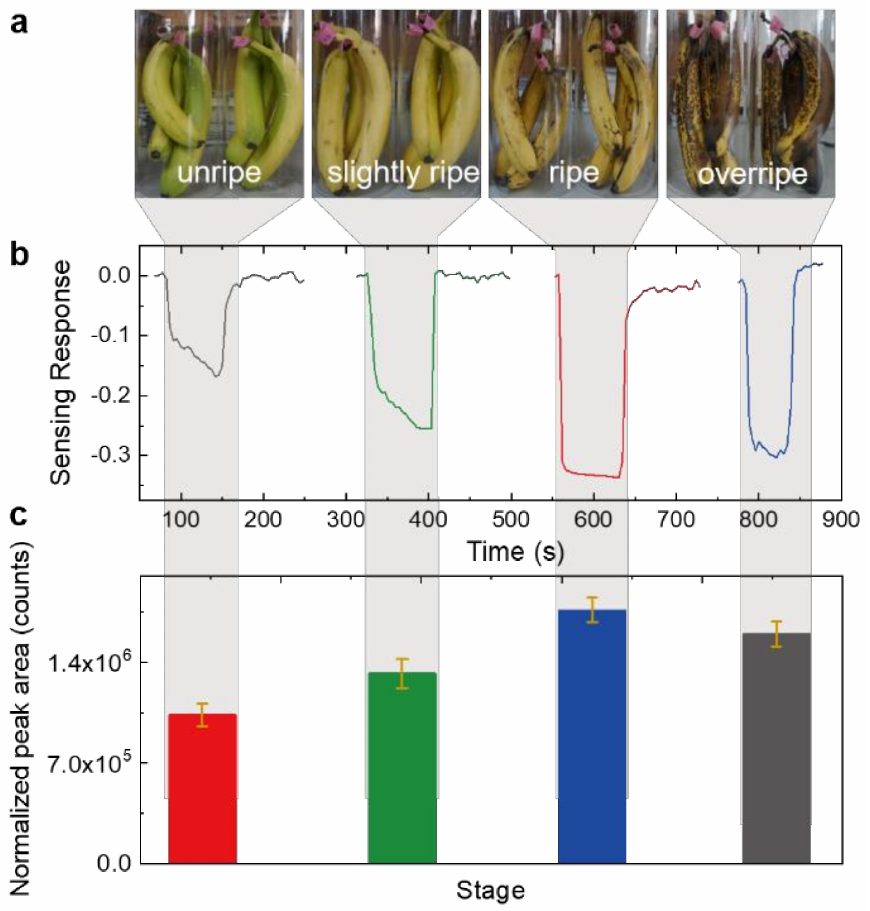
Figure 5. ( a ) Photos of banana samples at different storage stages: yellowish green (1st stage, unripe), all yellow (2nd stage, slightly ripe), all yellow with brown speckles (3rd stage, ripe), and dark brown (4th stage, overripe). ( b ) The real-time resistance versus time curves of the rGO/WSe 2 /Pd heterojunction-based chemiresistive sensor when placed into the sealed container with bananas at different ripeness stages. ( c ) The normalized peak area of released ethylene from banana samples at different ripeness stages by GC-MS